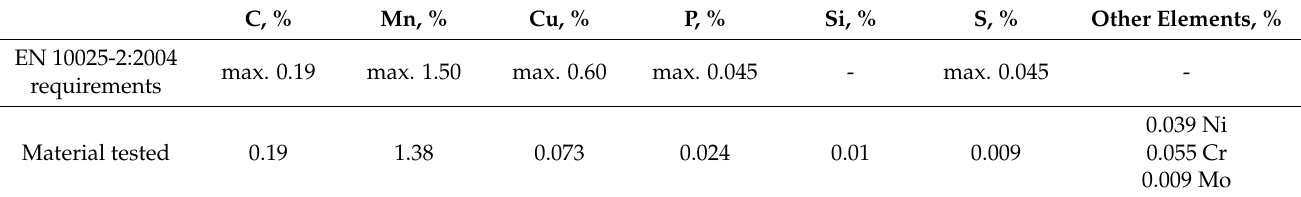
Table 1. Chemical composition of the steel tested (wt. %).